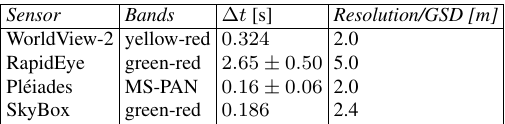
Table 3: Overview of time gaps and bands used for the investi- gated sensors